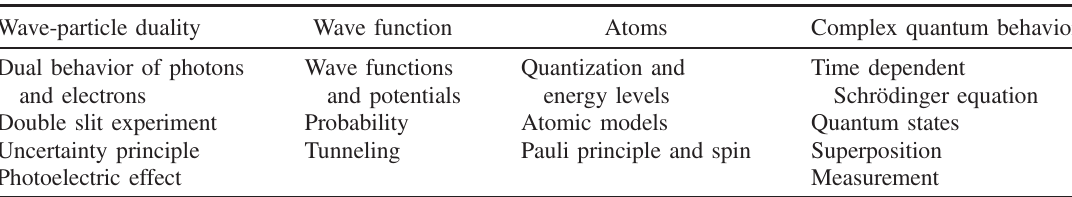
TABLE I. Quantum topics used for the analysis of the selected